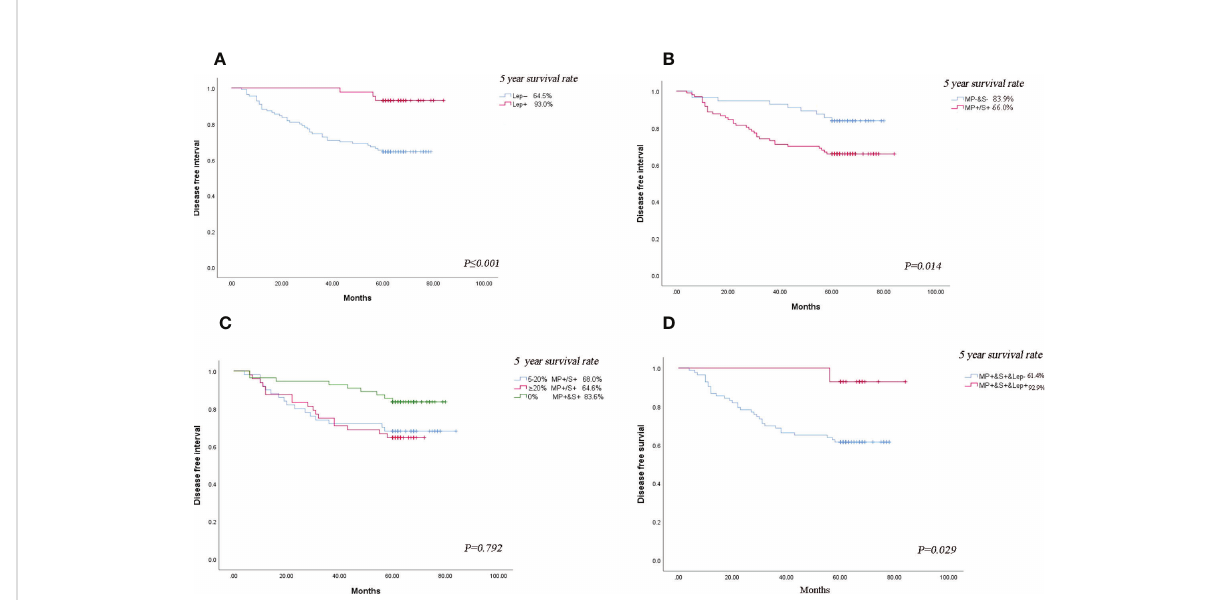
FIGURE 3 Subgroup analysis. (A) Comparison of DFS in patients with lung adenocarcinoma based on presence or absence of lepidic minor component. (B) Comparison of DFS in patients with lung adenocarcinoma based on the presence or absence of micropapillary/solid minor components component. (C) Comparison of DFS in patients with lung adenocarcinoma based on the proportion of micropapillary/solid minor components component. (D) Comparison of the effect of the presence or absence of lepidic component on DFS in patients with the micropapillary/solid minor component. The symbol of “ & ” means and.